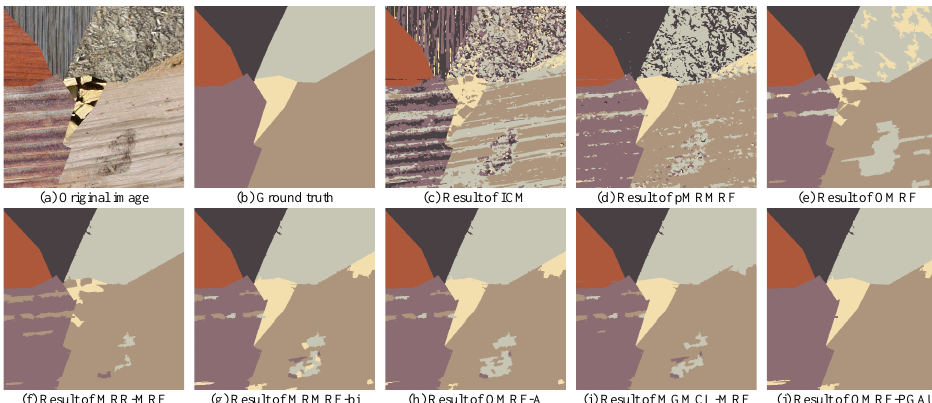
Figure 8. Semantic segmentation results for wood texture image.